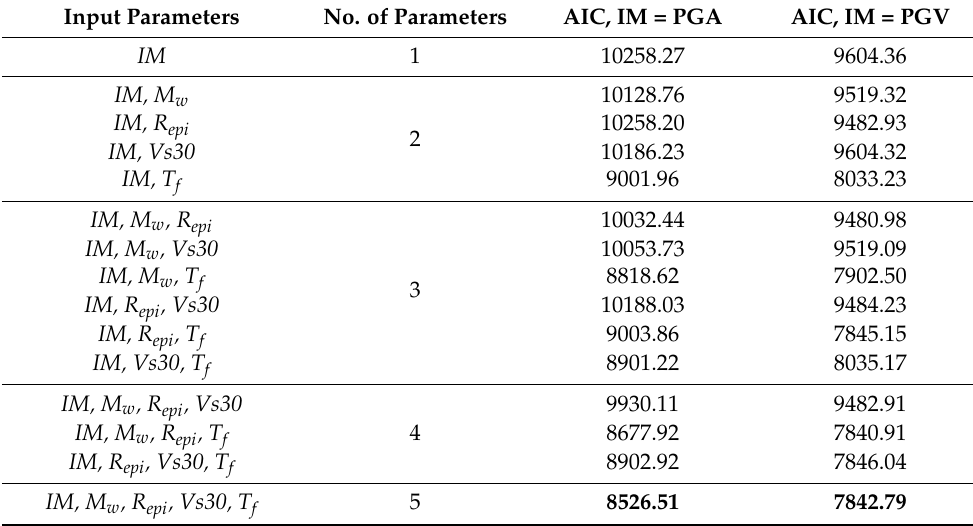
Figure 12. Variation of inter-story drift (ISD) ratio with Vs30 for SP, IP and LP structures ( a – c ). Black line indicates a moving window average of ISD. The mean ISD (black line) does not change significantly for different ranges of Vs30 . Table 6. Analysis of Akaike information